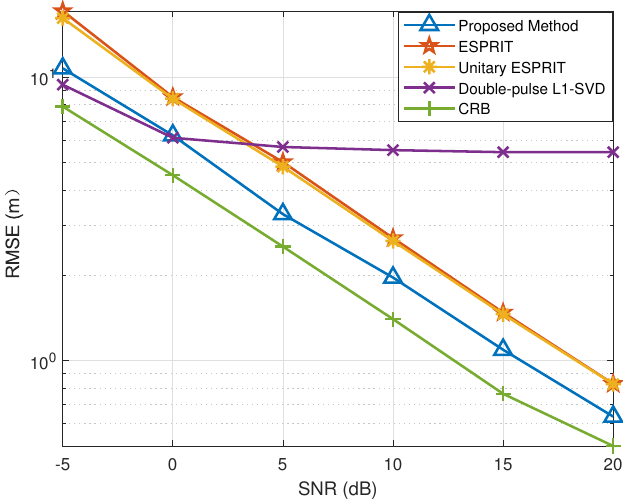
Figure 3. RMSE of DOA estimation versus SNR.